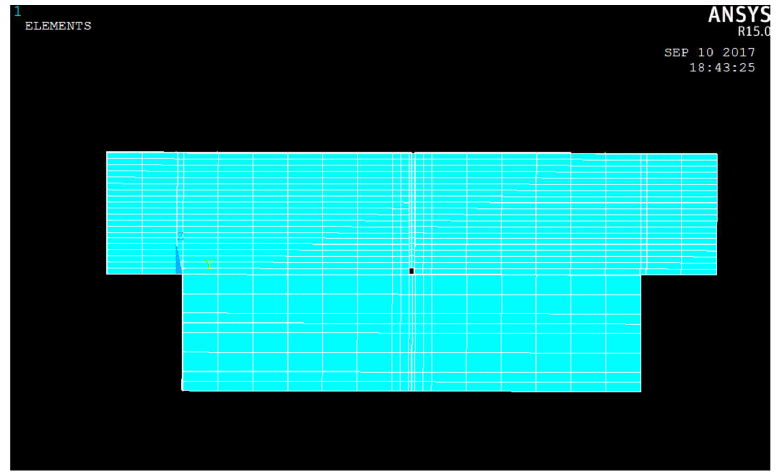
Figure 6. Numerical calculation model based on the OTs.